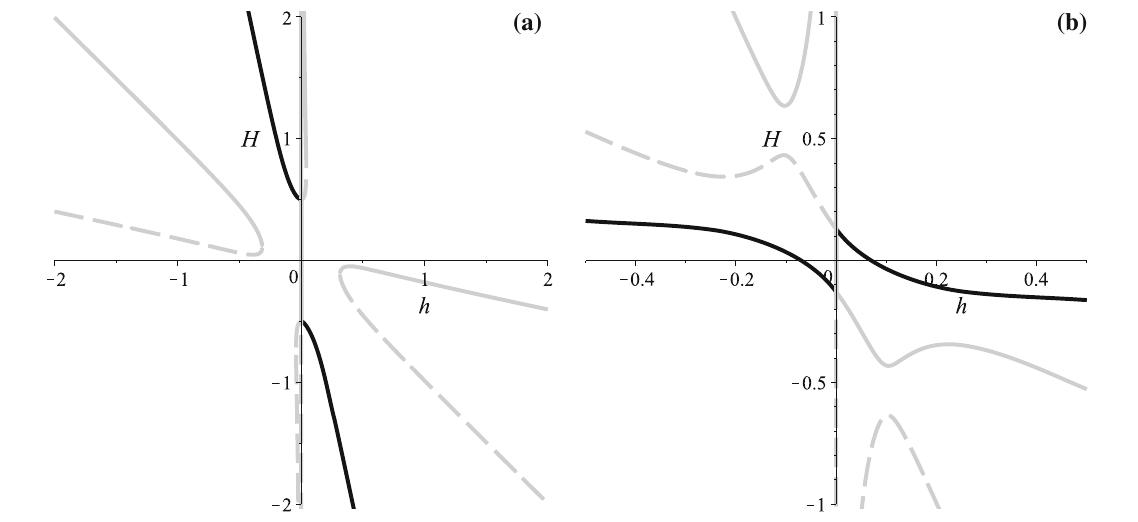
Fig. 5 Additional H ( h ) graphs for the D ≥ 4 case: α < 0, (cid:2) > 0, α(cid:2) < ζ 3 in a and α > 0, (cid:2) > 0, α(cid:2) < ζ 2 in b . Different branches presented by different linestyle/color combinations: H 1 by solid black line , H 2 by solid gray and H 3 by dashed gray (see the text for more